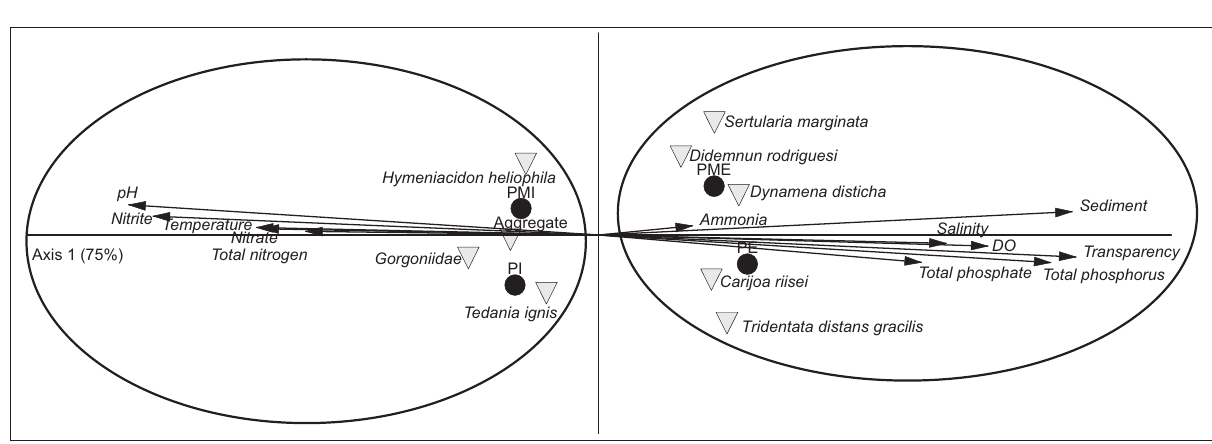
Figure 17. Canonical correlation analysis (ACC) including the representative taxa (> 5% coverage in at least one quadrat – triangles) and descriptors (environmental parameters and inorganic nutrients – arrows) for the four study stations (black circles): PI (Internal Station), PMI (Internal Midpoint), PME (External Midpoint) and PE (External Station) along the Vitória